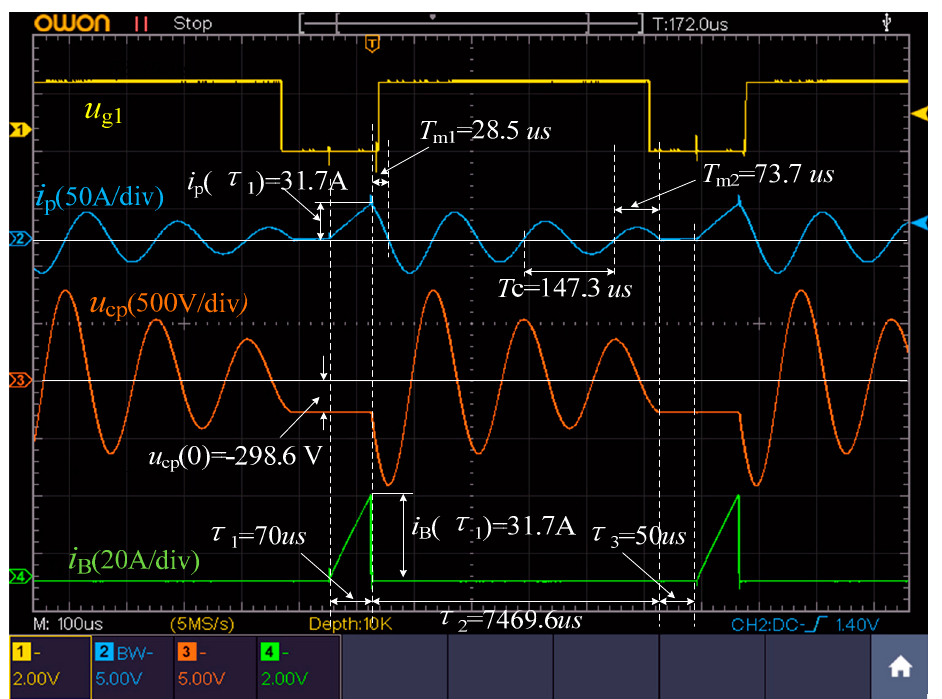
Figure 12. The experiment result of the IIEIFR ICP system.